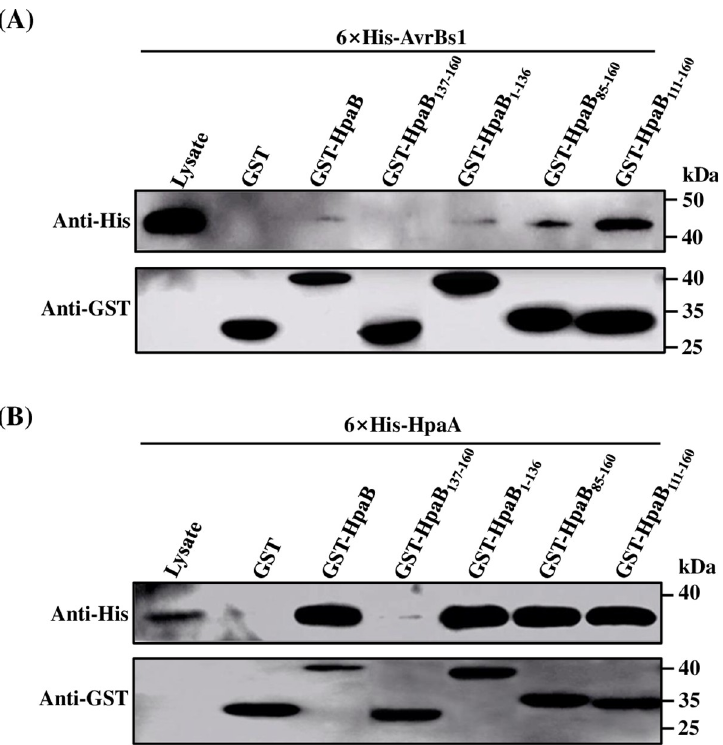
Fig 4. The C-terminal domain of HpaB is dispensable for interaction with T3Es in Xcc . ( A-B ) GST alone and GST- fused HpaB derivates were immobilized on MagneGST TM particles and incubated with cell lysates containing 6 × His- AvrBs1 ( A ) and 6 × His-HpaA ( B ), respectively. Samples were analyzed using immunoblotting with hexahistidine- specific antibody and GST-specific antibody.